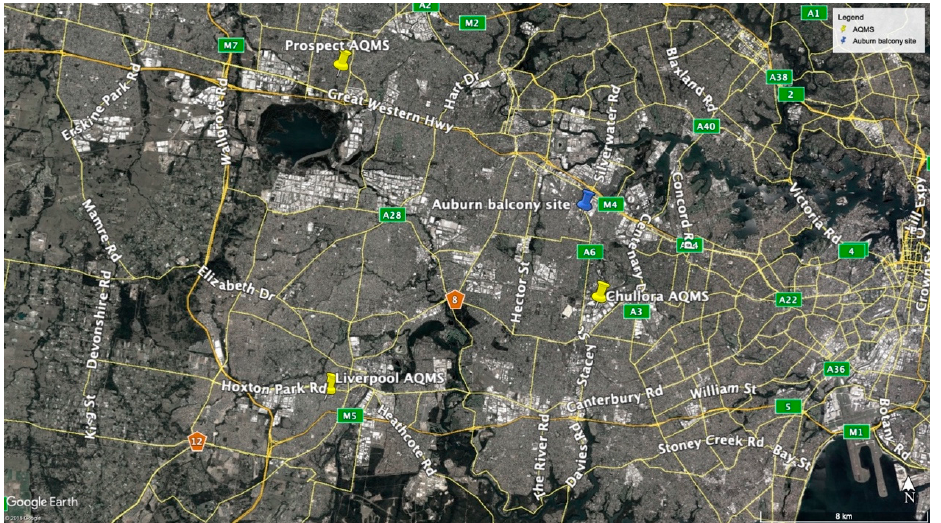
Figure 2 . Map showing the around the WASSPS-Auburn campaign site (indicated by the blue pin), including surrounding air quality monitoring stations (yellow pins), generated using Google Earth ®.